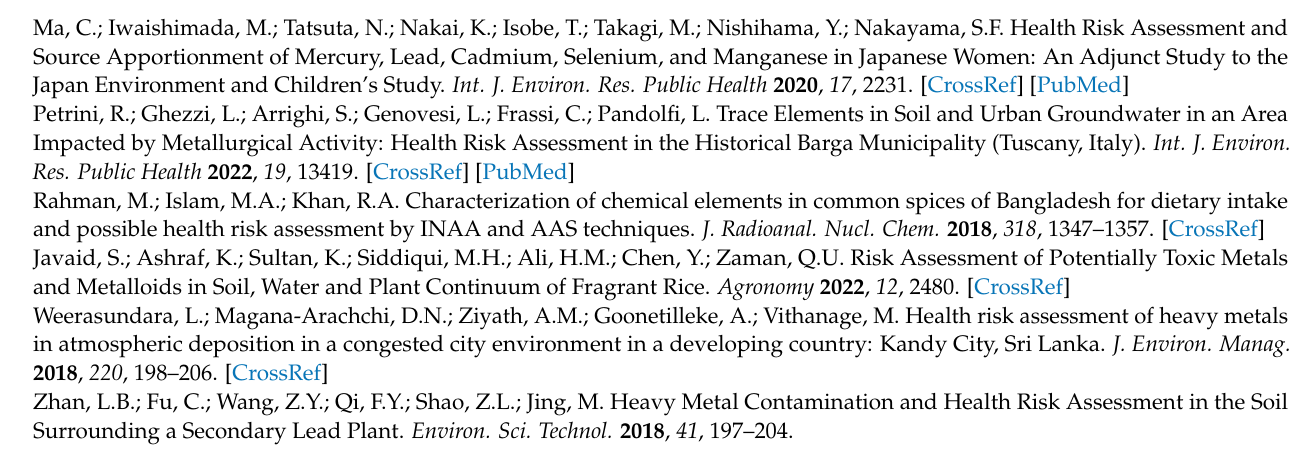
Table S2: Effect of extraction time for Cd and Pb; Table S3: The effect of the setting mode and time for Cd and Pb; Figure S1: Influence of different acid concentration (n = 3): (a) Cd and (b) Pb; Figure S2: Influence of different grain diameter (n = 3): (a) Cd and (b)Pb; Figure S3: Influence of the ratio of solid to liquid (n = 3): (a) Cd and (b) Pb; Figure S4: Influence of the extraction temperature (n = 3): (a) Pb in brown rice, (b) Pb in wheat, (c) Pb in maize, (A) Cd in brown rice, (B) Cd in wheat, and (C) Cd in maize, the dotted line represents the expanded uncertainty of the certified value, U crm = k · u crm (k =